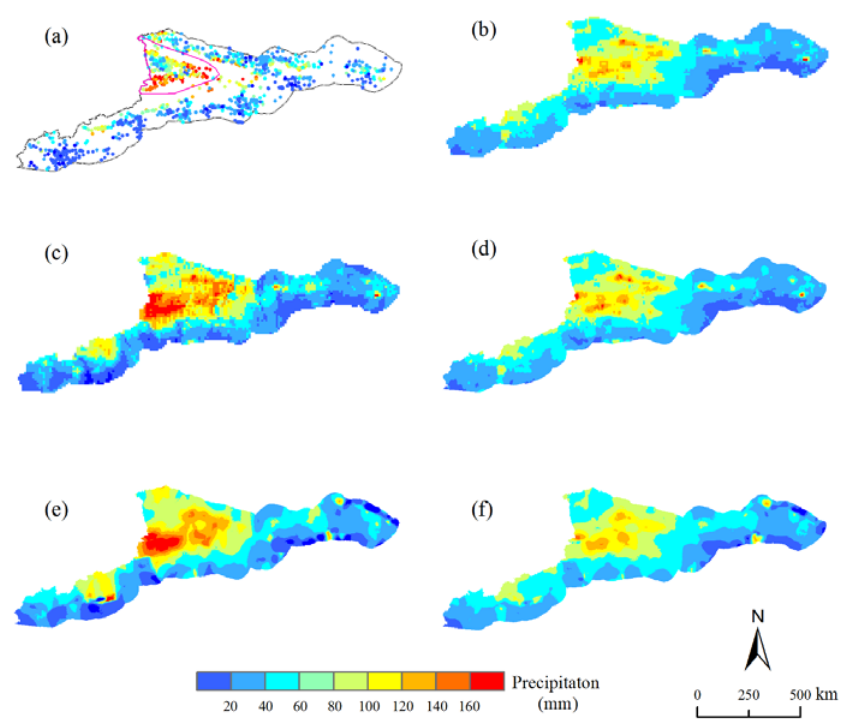
Figure 9. The spatial distributions of the five estimated precipitation datasets and the observed precipitation in July 2016. ( a ) OBS; ( b ) OIMERG; ( c ) CIMERG; ( d ) DS_Spline; ( e ) DS_CIMERG; ( f ) DS_OIMERG.